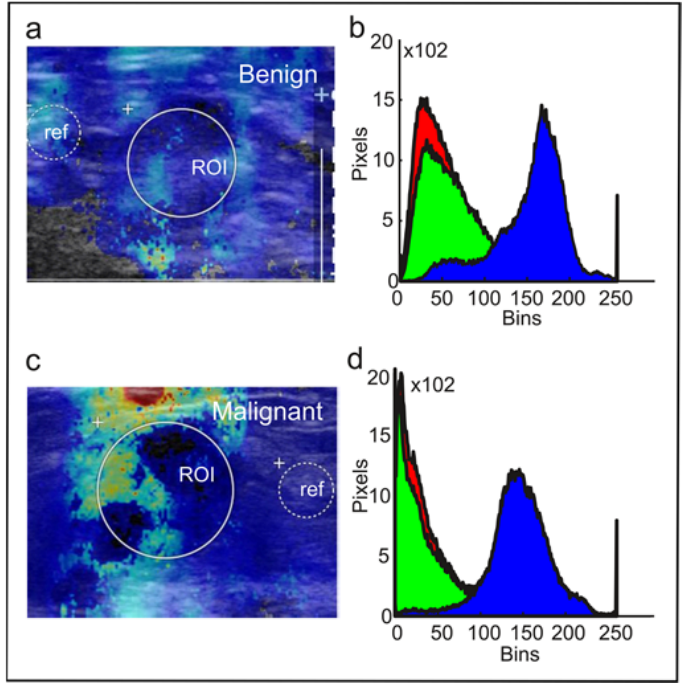
Figure 3. Sample elastogram and histograms. ( a ) Sample image of a benign breast lesion, ( b ) RGB histogram of the lesion ( a ), ( c ) sample image of a malignant breast lesion, and ( d ) RGB histogram of the lesion in ( c ). ROI, region of interest; ref, reference region (adjacent fat pad).